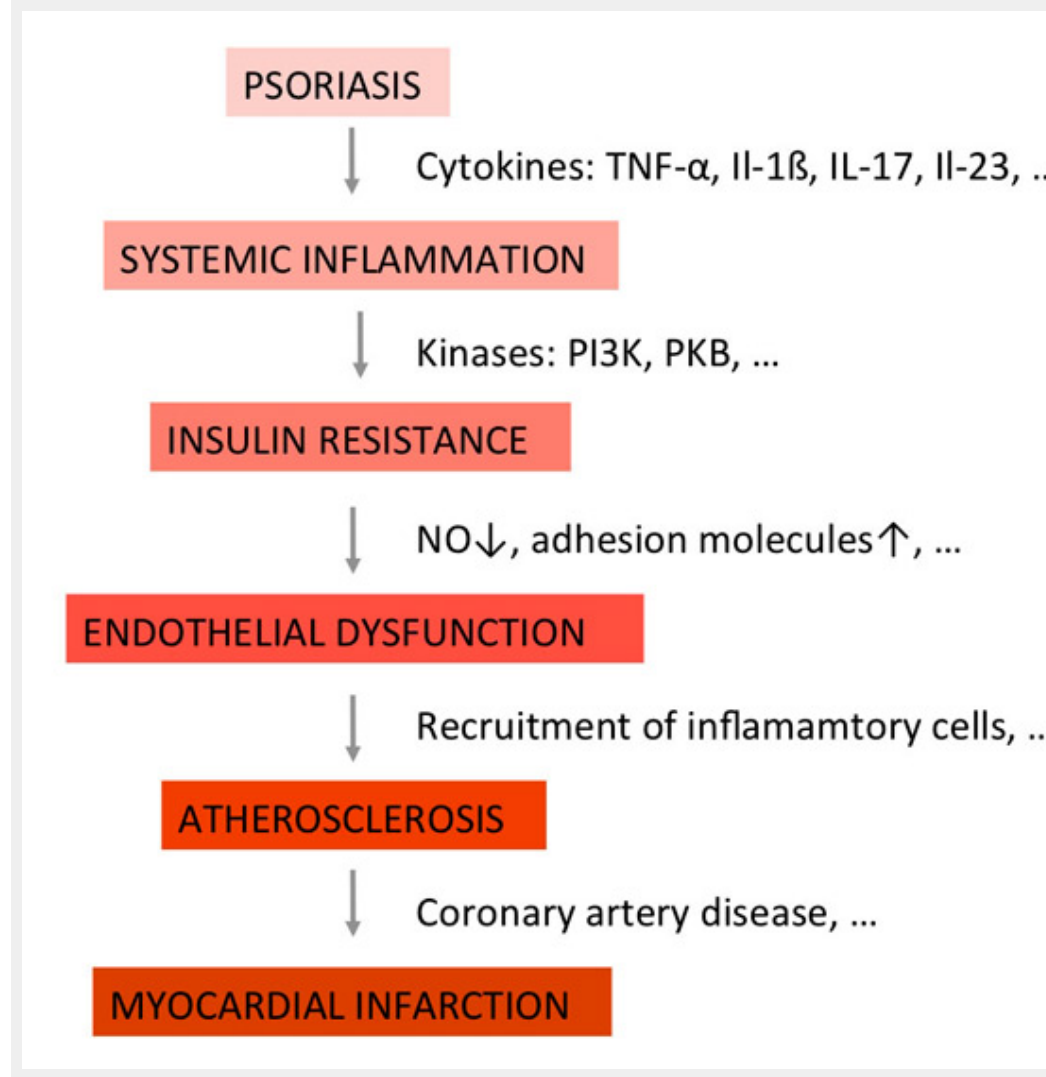
Figure 2 The concept of the “psoriatic march” (adapted from reference [25]). Psoriasis is considered a state of chronic systemic inflammation. Proinflammatory cytokines typically associated with psoriasis induce insulin resistance in endothelial cells, characterized by a reduced release of vasodilating factors such as NO. The resulting state of endothelial dysfunction comprises additional features such as expression of adhesion molecules, and provides the basis for the formation of atherosclerotic plaques. IL = interleukin; NO = nitric oxide; PI3K = phosphoinositide 3-kinase; PKB = protein kinase B; TNF = tumour necrosis